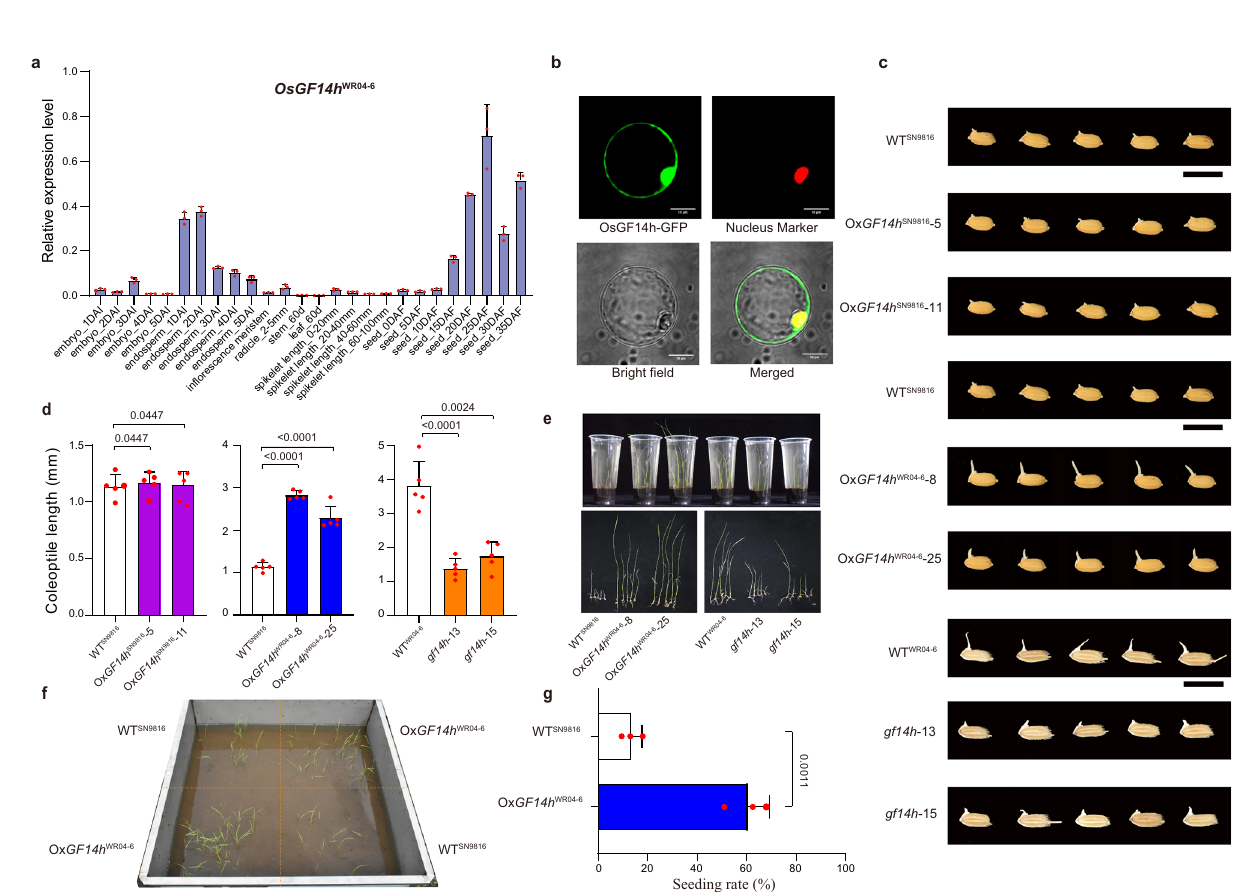
Fig. 1 | OsGF14h isolated from weedy rice is associated with anaerobic germi- nation (AG) based on QTL mapping and GWAS. a QTL mapping results in a LOD value threshold higherthan2.5. b ManhattanplotofGWASforAGwithathreshold of 8.12×10 − 7 (0.05 signi fi cance level) and 1.62×10 − 7 (0.01 signi fi cance level). c Box plots for germination rate after 72-h anaerobic treatment (upper) and BLUP value among GJ-tmp-weedy , GJ-tmp-land , and GJ-tmp-cul from the GWAS panel (lower). Dots represent the accessions, n =190 biologically independent samples. Center lines show the medians, boxlimits indicate the 25th and 75th percentiles, whiskers extend to the 5thand 95th percentilesasdeterminedby R software. d PCA plot for the GWAS panel and dots represent the accessions, n =190 biologically indepen- dent samples. e Quantile-quantile plots (QQ plots) of GWAS and plots corre- sponding to the GWAS Manhattan plot. f Linkage disequilibrium plot for SNPs